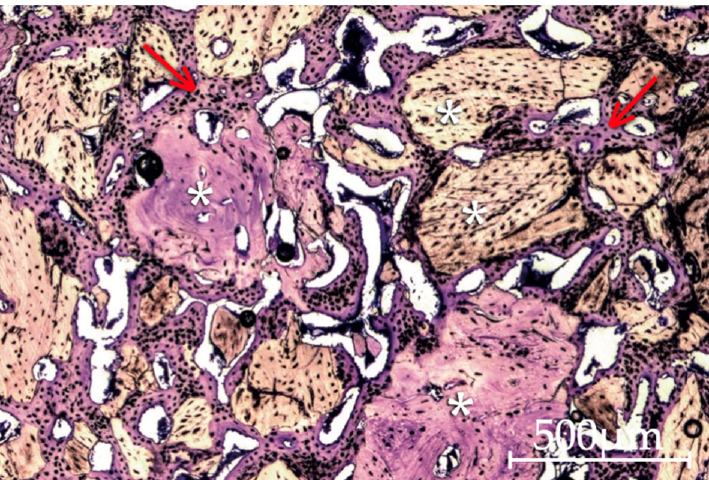
Figure 4. Image of the mp3 group at 30 days of evolution. The formation of an extensive network of bone trabeculae (arrow) is notorious, integrating and linking the bone graft material particles (asterisk). A certain heterogeneity in the shape, dimensions and tinting characteristics of the mp3 particles may also be perceived (40 × original